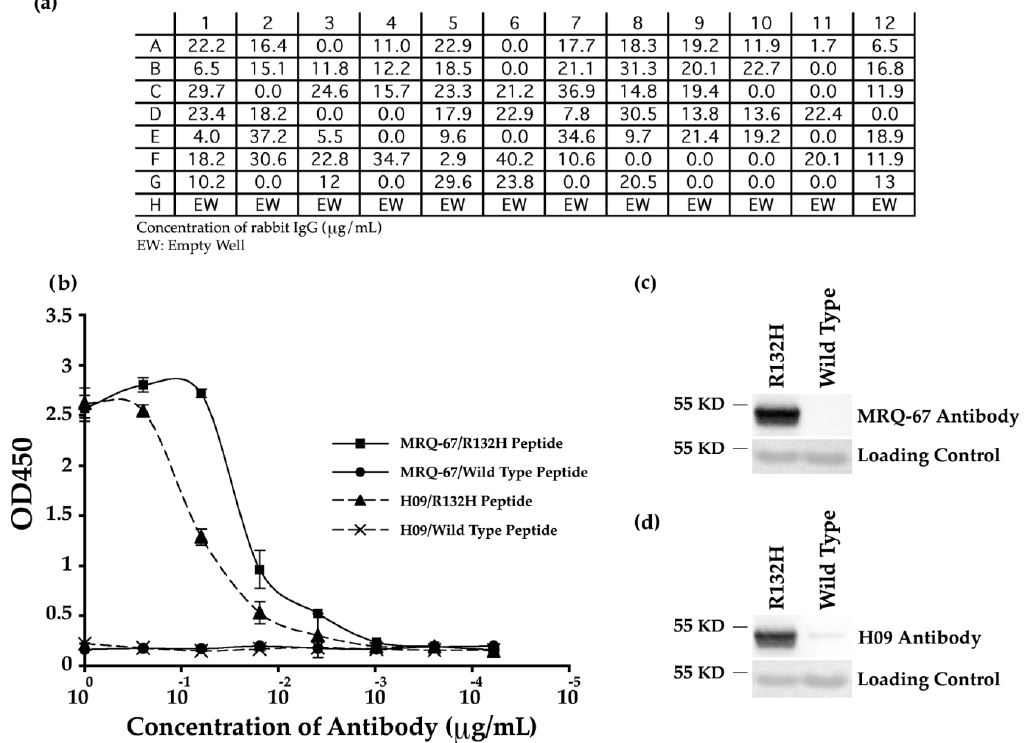
Figure 1. Generation and performance of rabbit monoclonal MRQ-67 antibody against IDH1 R132H and comparing its function with the H09 antibody by Enzyme-linked immunosorbent assay (ELISA) and Western blotting assays: ( a ) The concentration of antibody generated by clones was measured in µg/mL by rabbit IgG ELISA kit; ( b ) Peptide binding ELISA. MRQ-67 antibody specifically recognized only mutant IDH1 R132H peptide and not wild type IDH1 peptide. The ELISA binding assay result for the H09 antibody has been included as a control; ( c , d ) Analysis of MRQ-67 and H09 for detecting recombinant human IDH1 R132H and recombinant human IDH1 wild type proteins in Western blotting. MRQ-67 ( c ) and H09 ( d ) antibodies (0.5 µ g/mL) were used to probe the membranes. Coomassie blue stainings of the proteins are shown as loading control.